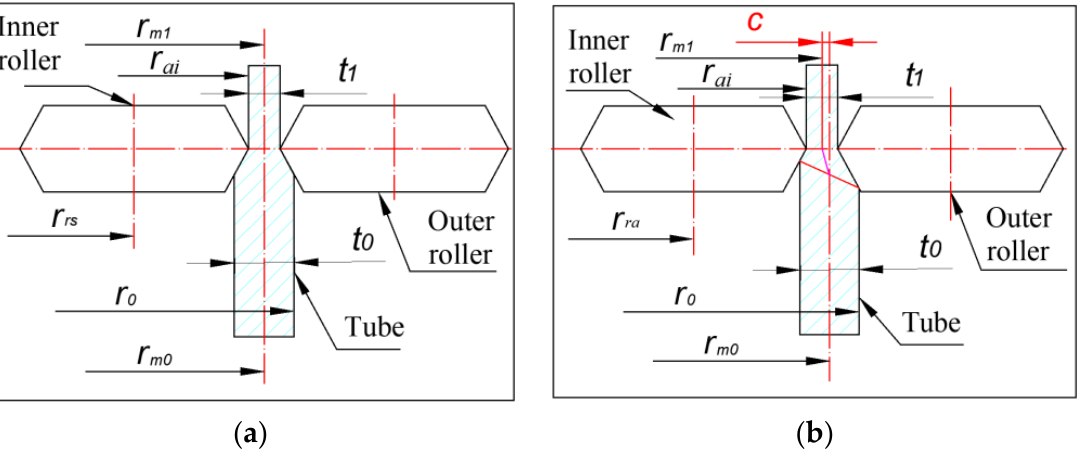
Figure 1. The comparison between different counter-roller flow-forming (CRFF) processes: ( a ) Symmetrical counter-roller flow-forming (SCRFF); ( b ) Asymmetrical counter-roller flow-forming (ACRFF). The difference between the general symmetric counter-roller flow-forming (SCRFF) process and the asymmetric counter-roller flow-forming (ACRFF) process is shown in Figure 1b. The tube’s inner and outer deformation regions are the same as in the general SCRFF process. Although the tube blank thickness t 0 is reduced to t 1 after the general SCRFF process, the middle radius of the final flow-formed tube r m 1 equals to the middle radius of the tube blank r m 0 . The thickness reduction ratio